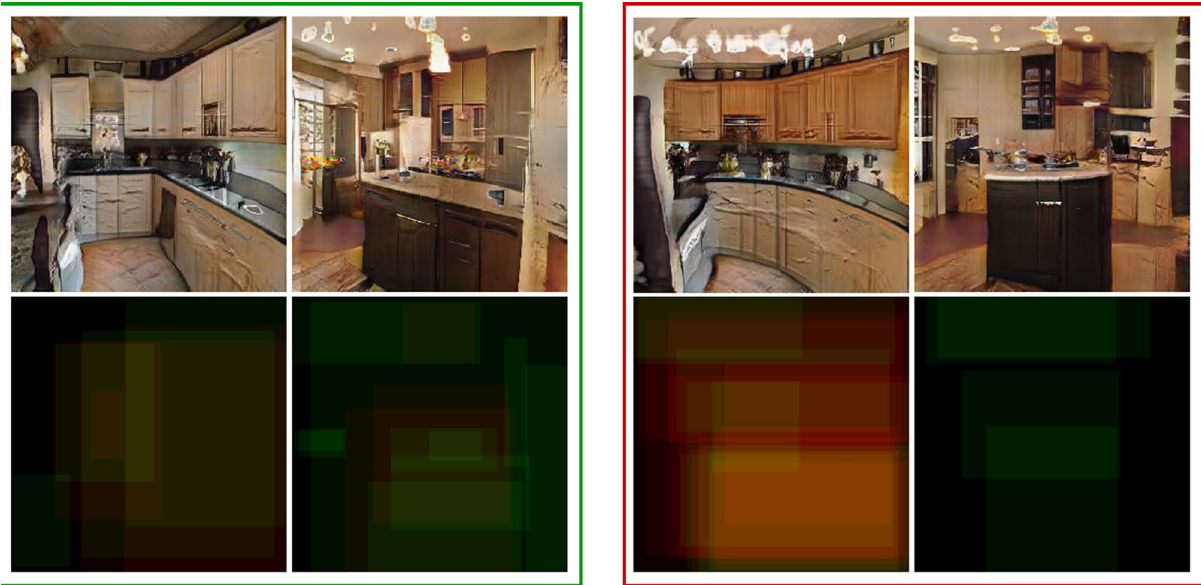
Figure 6. Generated high-memorability images (left) and their low-memorability pairs (right). VMS maps for each image are shown on the bottom row.